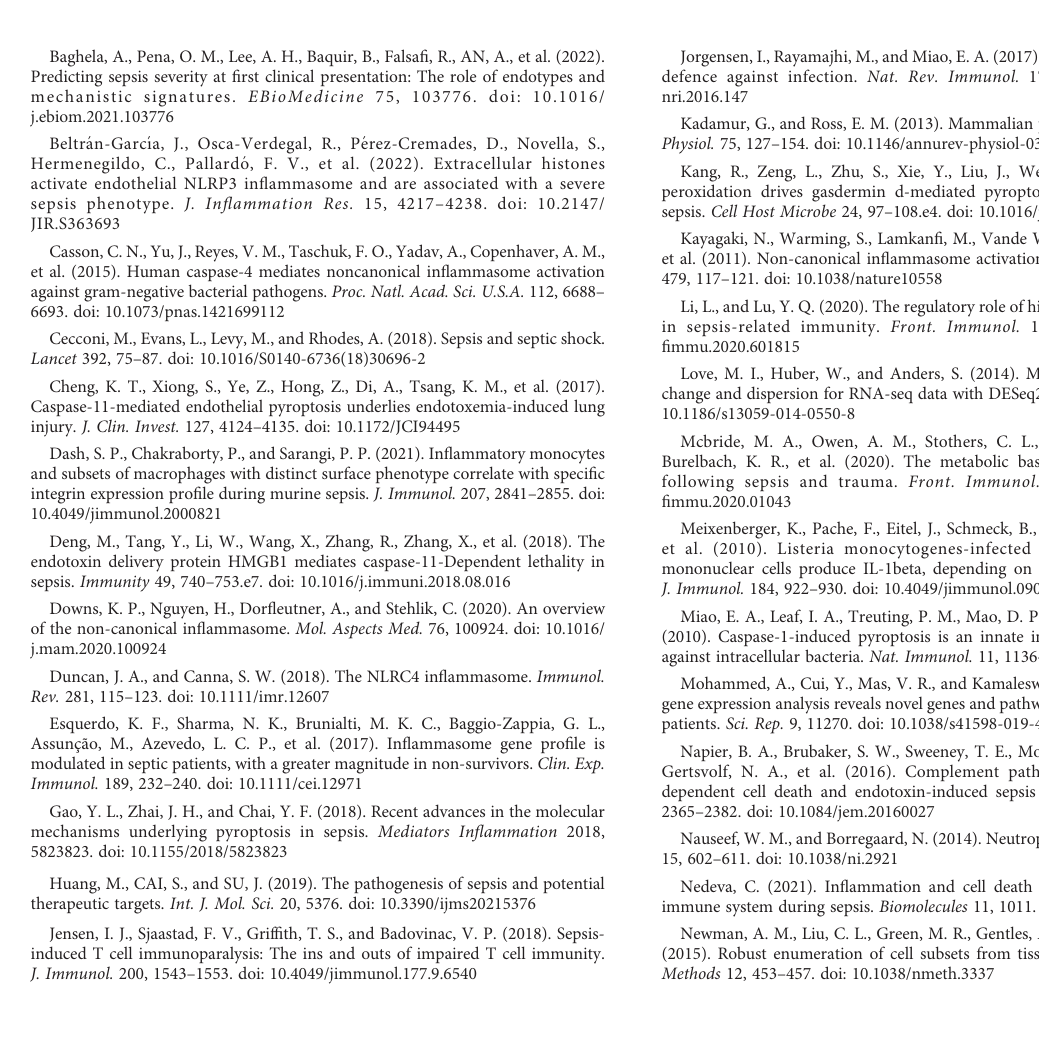
SUPPLEMENTARY FIGURE 1 The difference in immune in fi ltration between sepsis and septic